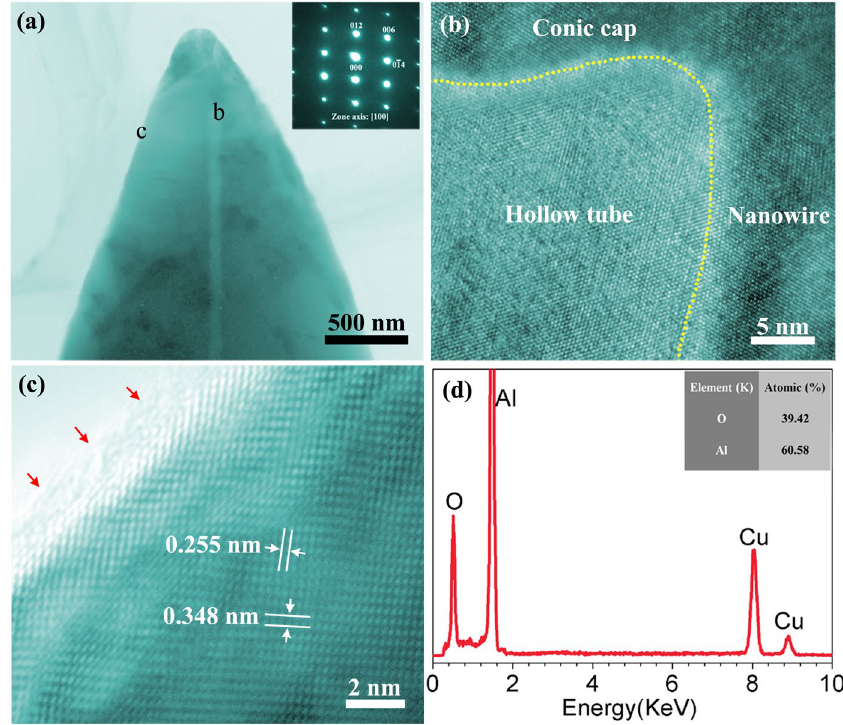
Figure 2. ( a ) TEM image of the individual α -Al 2 O 3 nanowire with a conical tip (The inset is the corresponding SAED pattern); ( b ) HRTEM image of the areas marked as “b”; ( c ) HRTEM image of the areas marked as “c”; ( d ) EDS spectrum obtained from the individual α -Al 2 O 3 nanowire (The inset is the ratio of O and Al